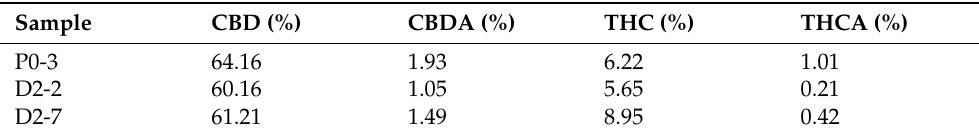
Table 1. Percentage of relative area of CBD, CBDA, THC, and THCA in different Cannabis sativa plant extracts.